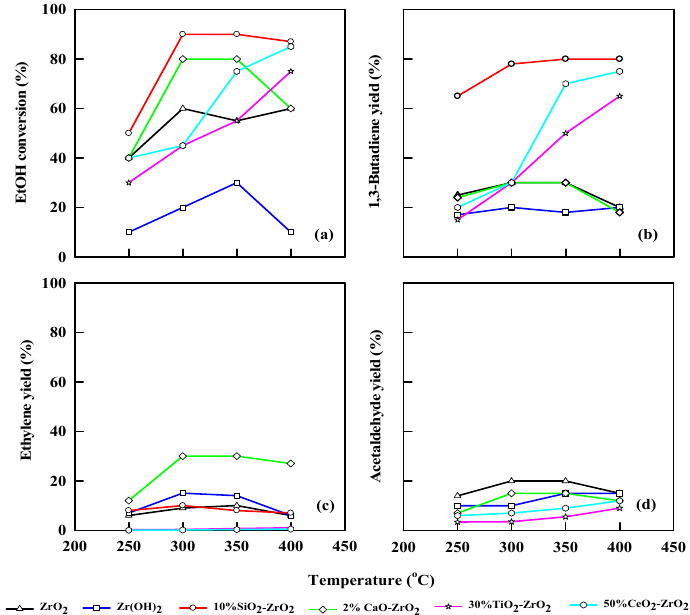
Figure 5. Plot of ethanol conversion ( a ), yields of 1,3-butadiene ( b ), ethylene ( c ), and acetaldehyde ( d ) vs. reaction temperature for different pretreated commercial catalysts. WHSV: 2.5 h − 1 , catalyst: 0.4 g, N 2 : 30 mL/min. Table 5. STY of 1,3-butadiene using different temperatures and pretreated catalysts.